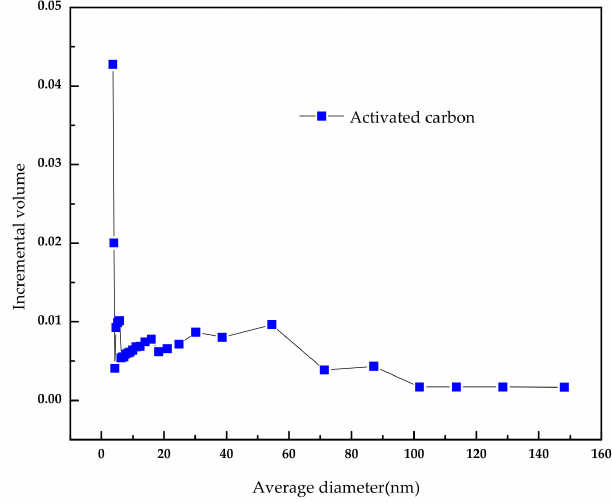
Figure 5. Activated carbonpore volume vs. average